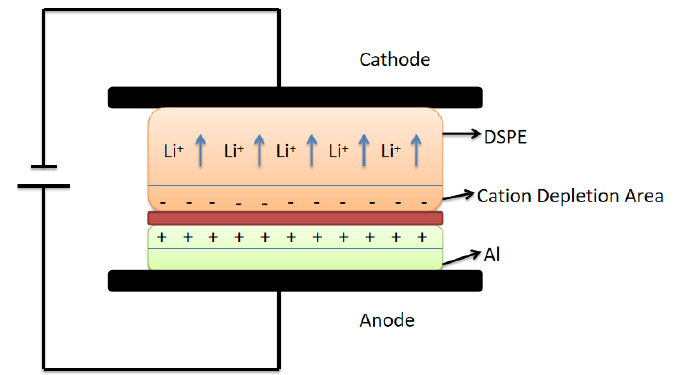
Figure 2. Schematic of ion migration and distribution during bonding.